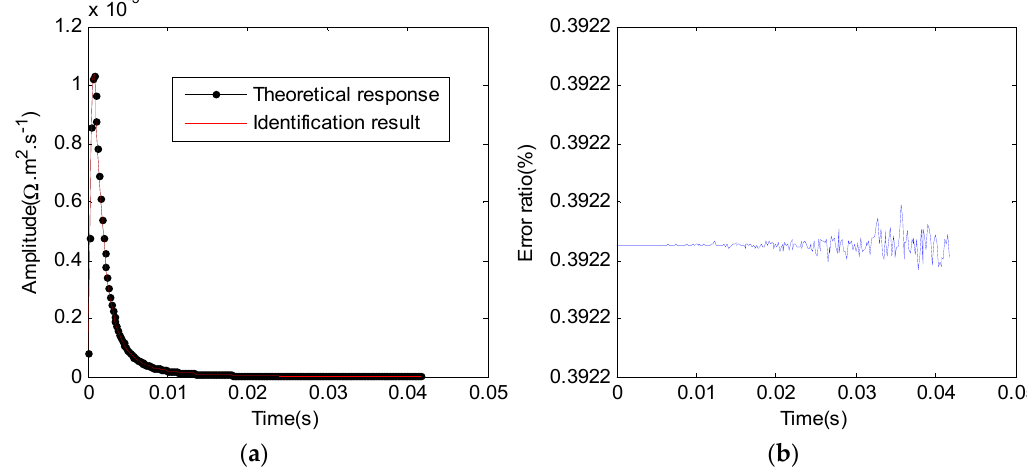
Figure 6. Identification results of cyclic convolution and cyclic correlation. ( a ) The earth impulse response extraction result; ( b ) identification error.